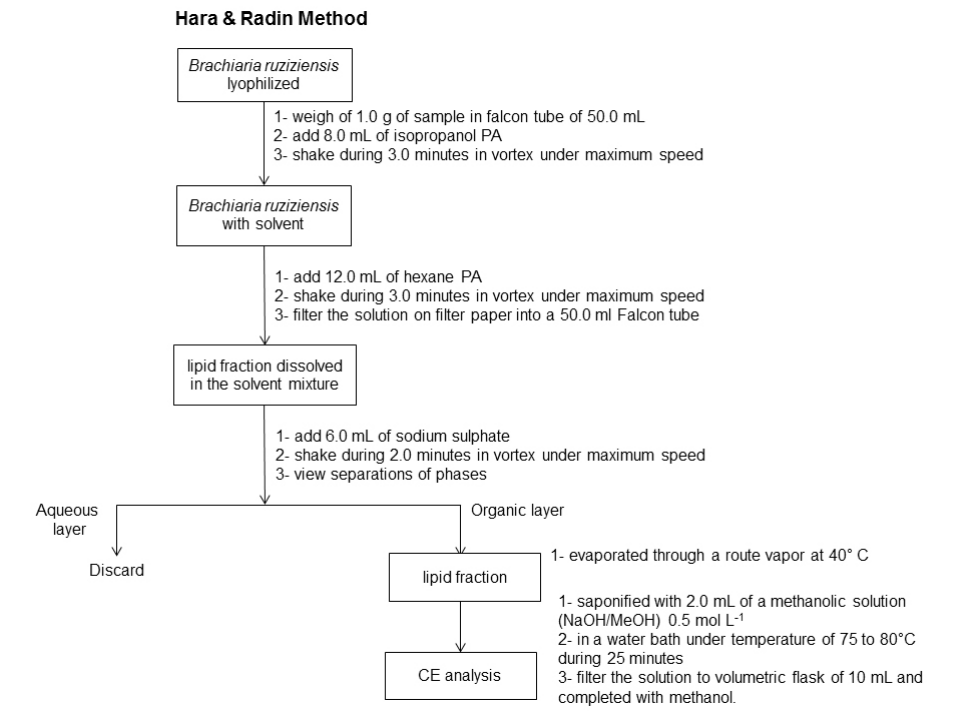
Figure 2. Hara and Radin extraction methods flow